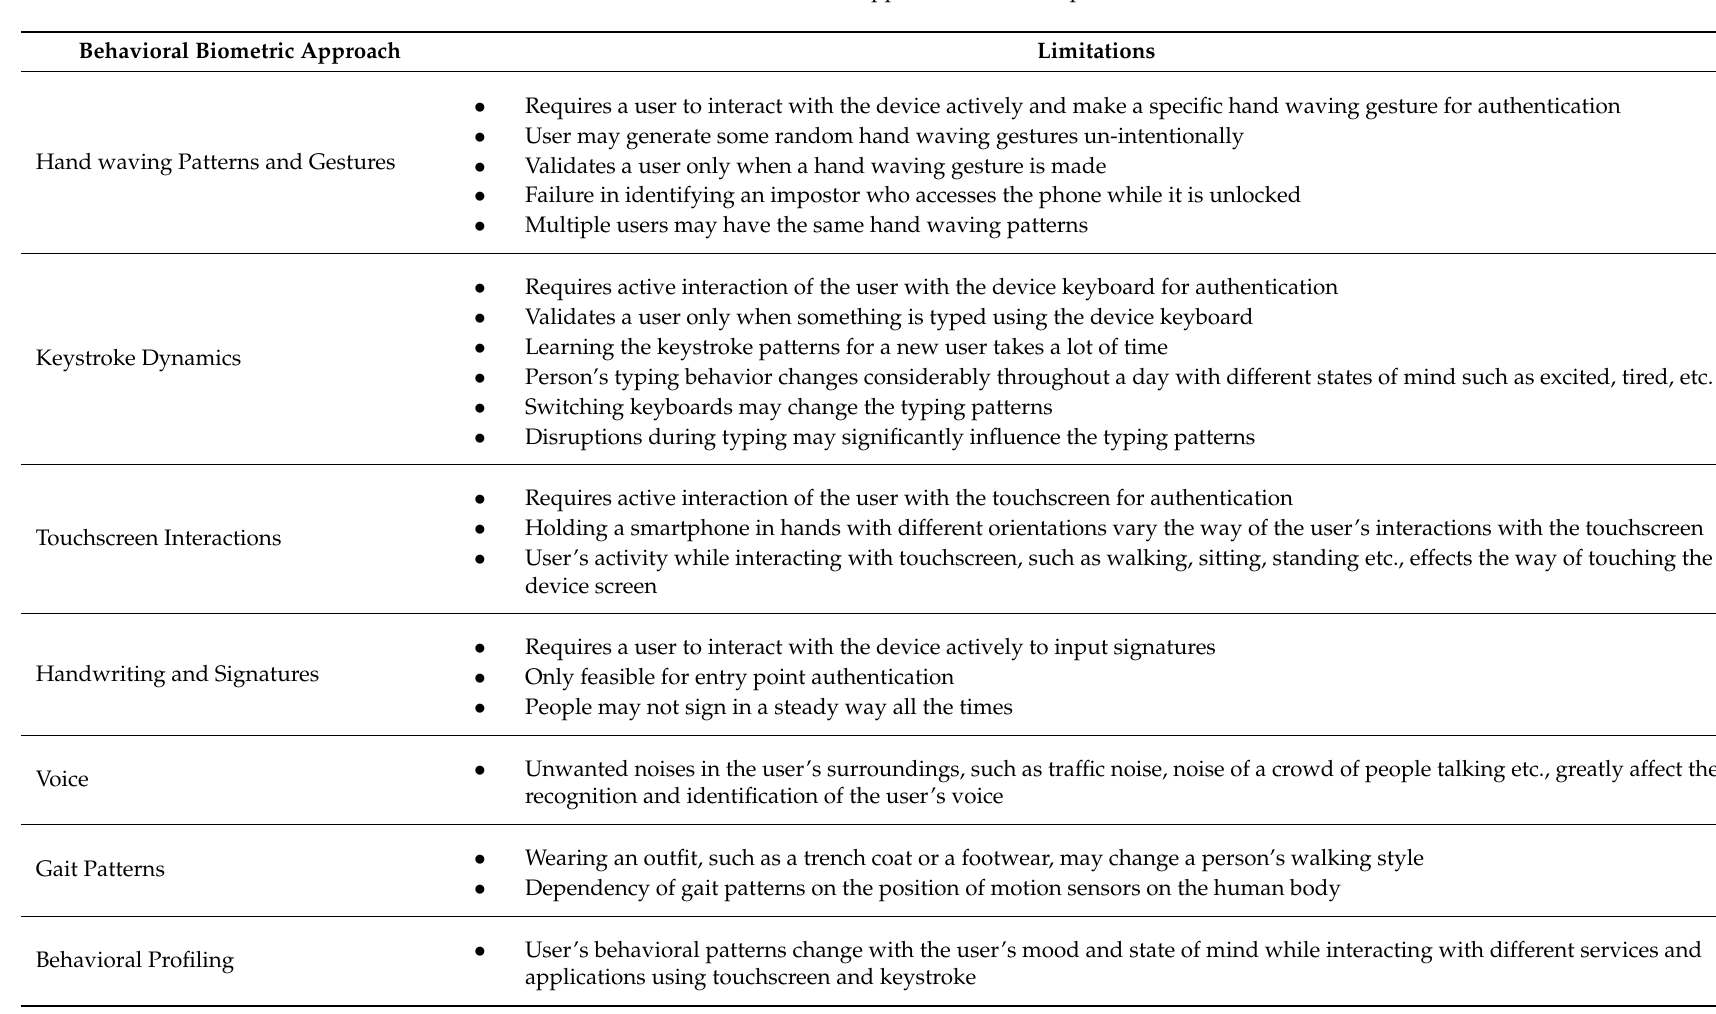
Table 2. Limitations of behavioral biometric approaches for smartphone user